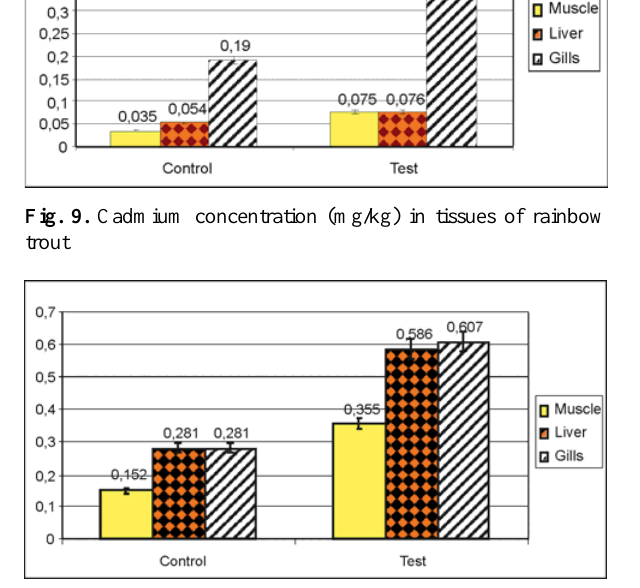
Fig. 10. Nickel concentration (mg/kg) in tissues of stone loach